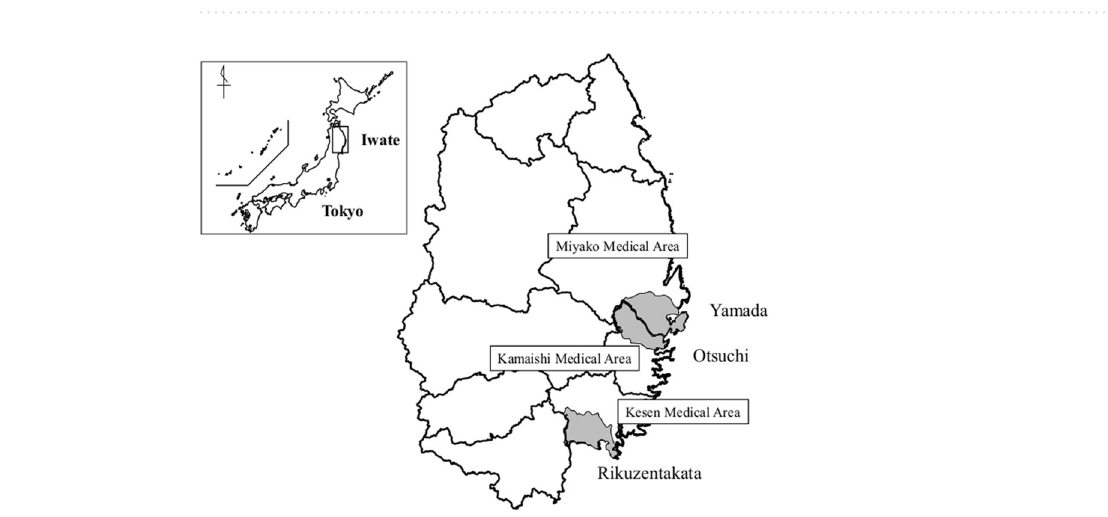
Table 3. Difference of data across the disaster among three municipalities.